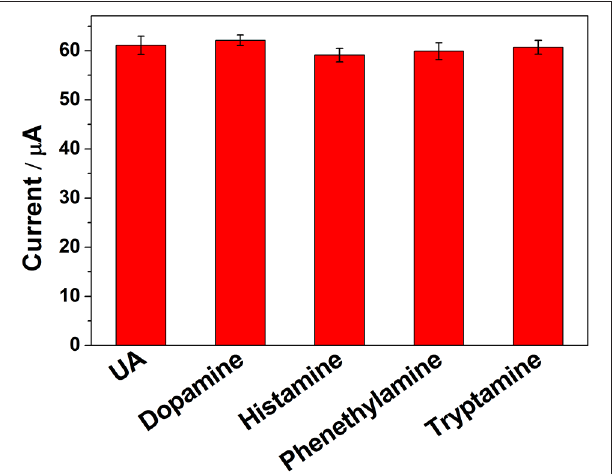
FIGURE 7 | The i pa response of ErGO-CP6/GCE in solution containing 2 µ M UA in the absence and presence of 10-fold dopamine, histamine, phenethylamine, and tryptamine, using DPV and keeping all the parameters